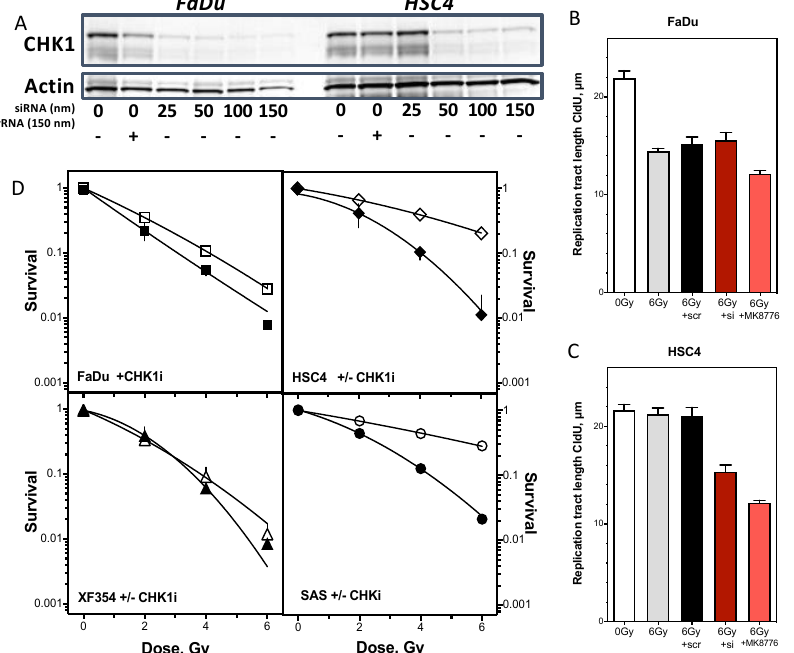
Figure 5. Inhibition of S phase checkpoint control radiosensitizes exclusively resistant HNSCC cell lines. ( A ) Concentration-dependent inhibition of CHK1 by siRNA treatment in FaDu and HSC4 cells. ( B , C ) Effect of siRNA or CHK1 inhibitor MK8776 treatment in combination with irradiation on replication tract length compared to irradiation alone. ( D ) Cellular radiosensitization only in resistant cell lines. Error bars represent the error of means of at least three independent experiments. (Student´s t